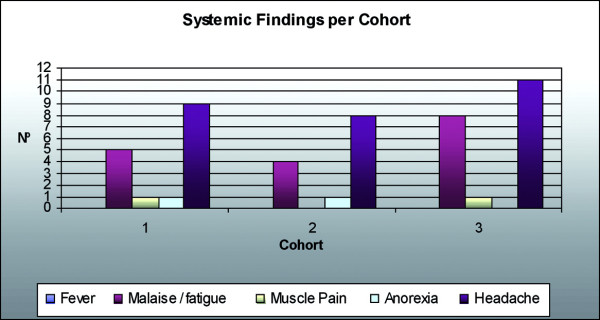
Systemic Reactogenicity following vaccination with Leish-111f + MPL-SE.